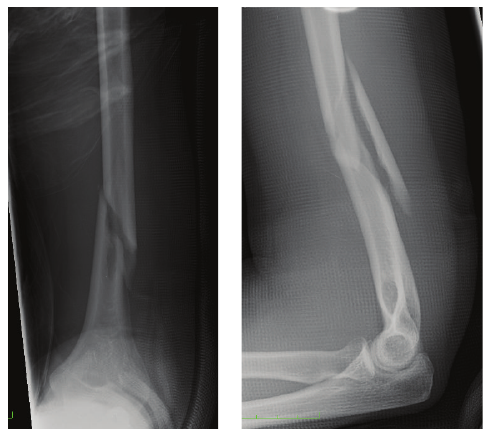
Figure 1: Preoperative anteroposterior and lateral radiographs of the slightly displaced distal humeral shaft fracture with a long wedge fragment.